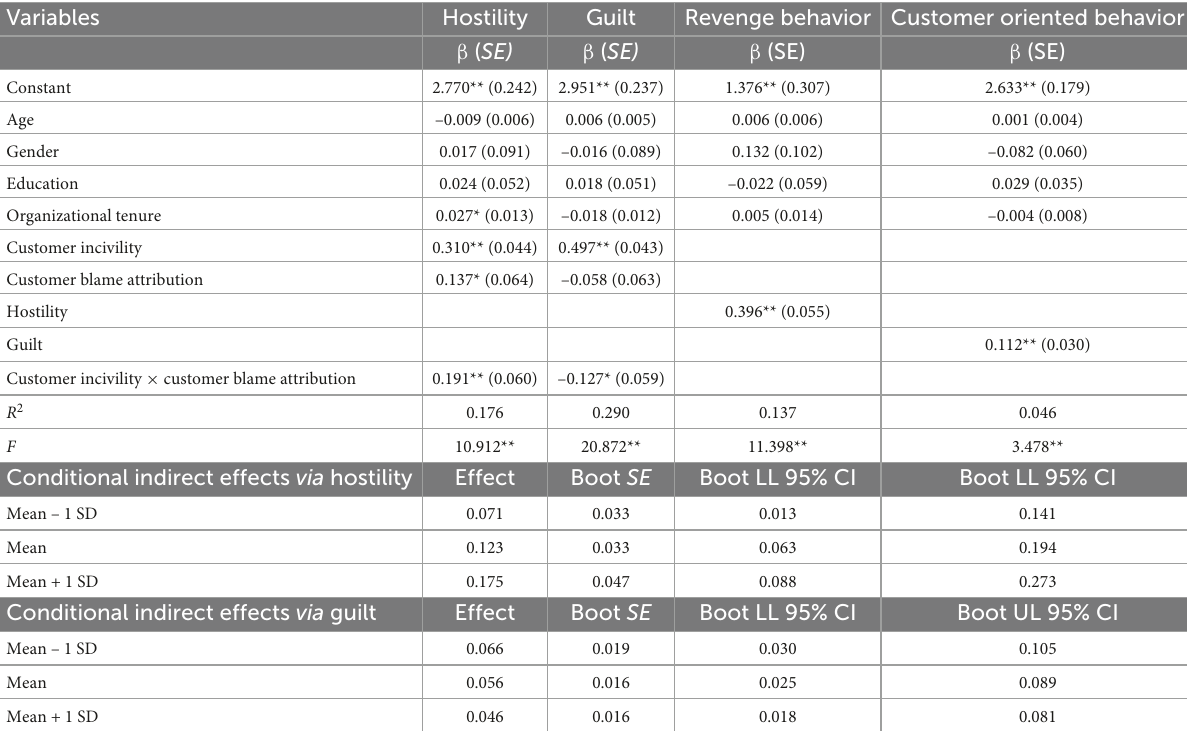
TABLE 3 Conditional process